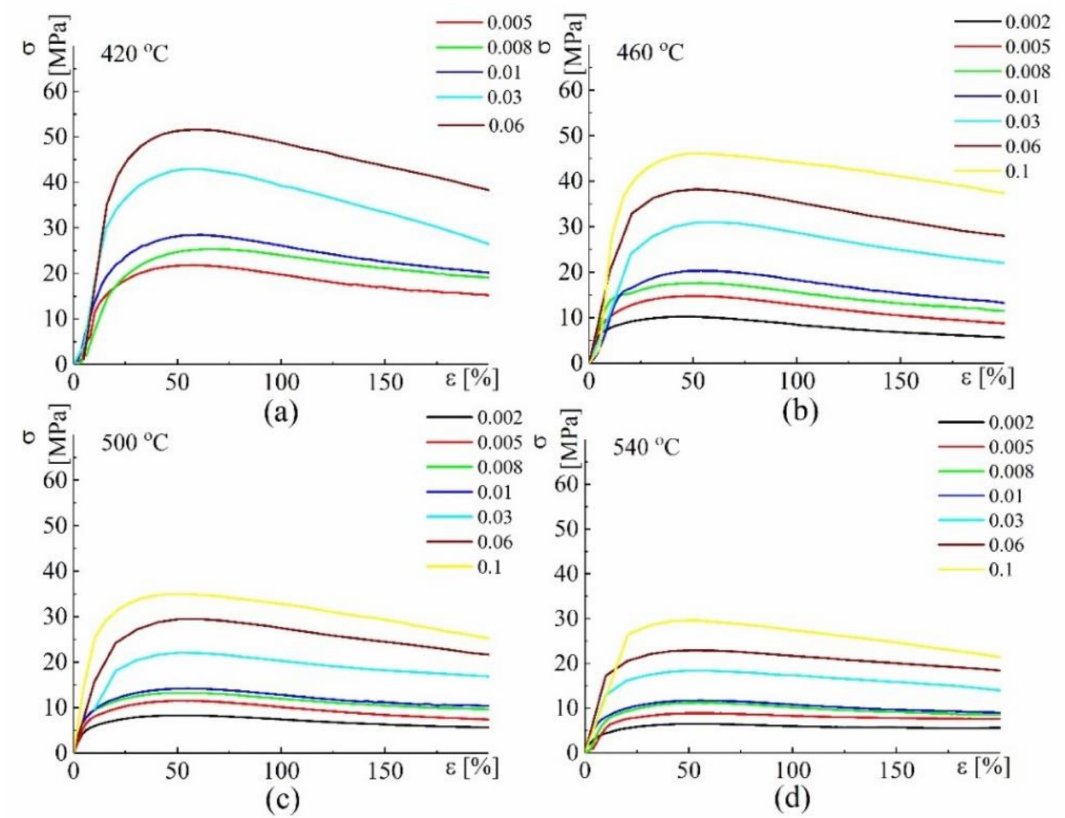
Figure 4. Experimental flow behavior at temperatures of ( a ) 420 ◦ C, ( b ) 460 ◦ C, ( c ) 500 ◦ C, and ( d ) 540 ◦ C with various constant strain